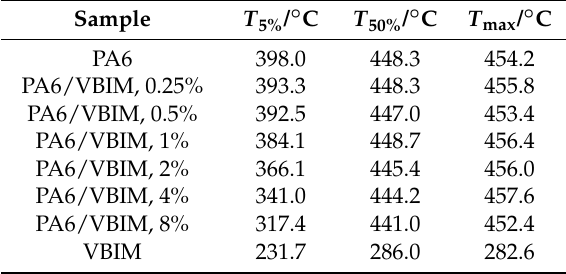
Table 2. TGA parameters of PA6 and the PA6/VBIM blends.